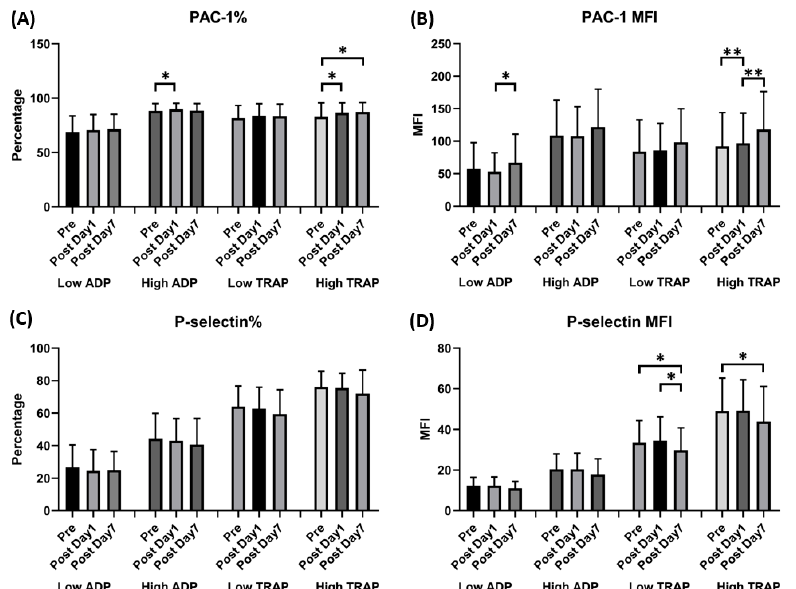
Figure 4. Expression of GPIIb-IIIa (PAC-1) and p -selectin in human platelets following ChAdOx1 nCoV-19 vaccination. ( A ) The percentage of platelet surface activated GPIIb-IIIa. ( B ) Platelet surface activated GPIIb-IIIa mean fluorescence intensity (MFI). ( C ) The percentage of platelet surface p -selectin. ( D ) Platelet surface p -selectin MFI (in the presence of the indicated concentrations of ADP or thrombin receptor-activating peptide [TRAP]). * p < 0.05; ** p < 0.01